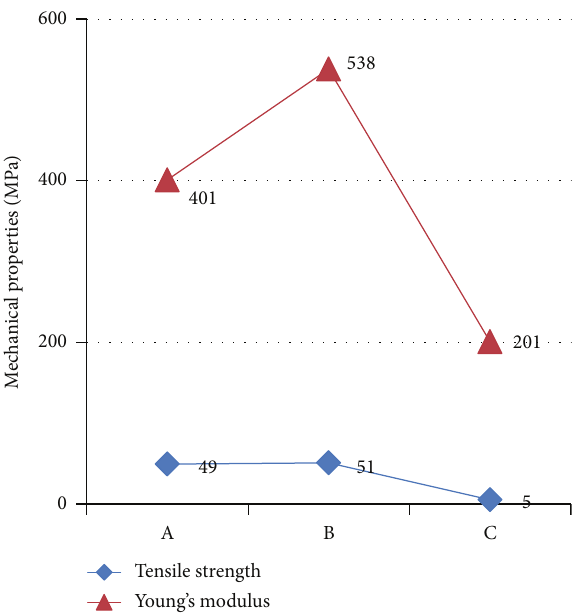
Figure 8: Hybrid GFRP mechanical properties of the three single type fibre.